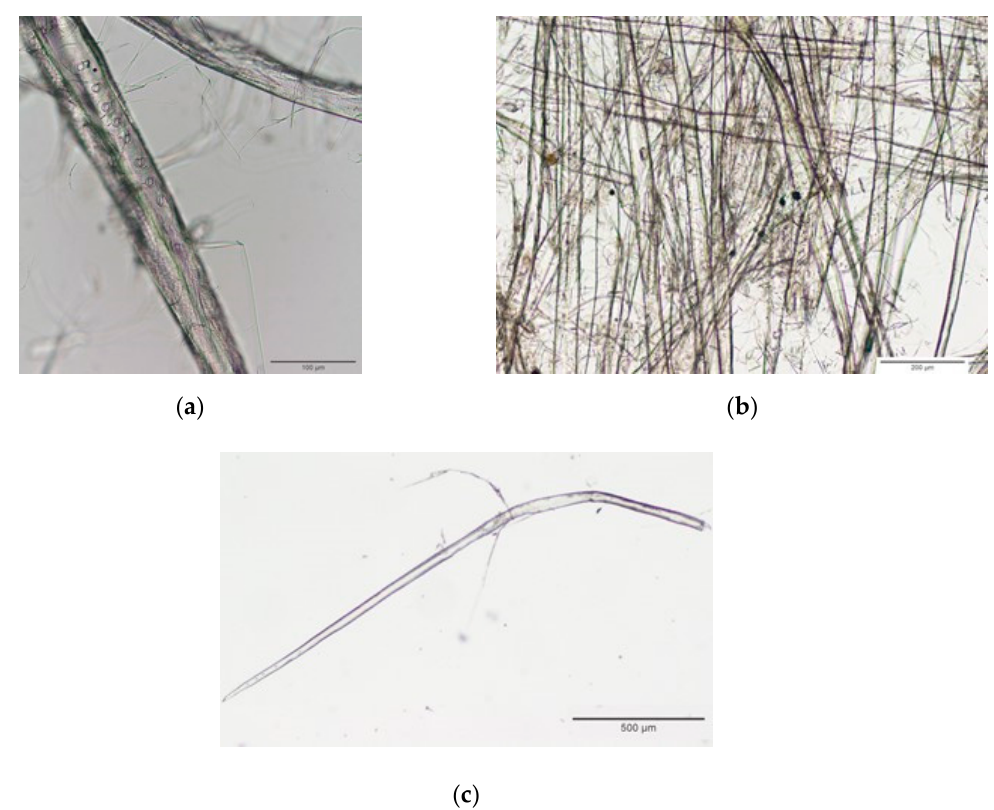
Figure 1. Optical microscopy of cellulose microfibers. The cellulose microfibers were assessed and visual inspected using the optical microscope OLYMPUS U-CMAD3 using the lens OLYMPUS Dx4, Dx10 and Dx20. Scale bar, 100 ( a ), 200 ( b ) and 500 µ m ( c ). Images were processed using Image J.